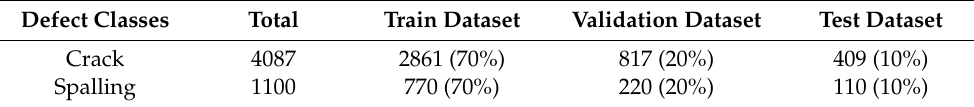
Table 2. Image distribution for classification